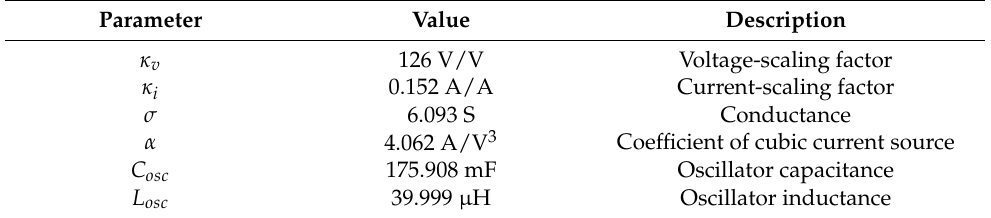
Table 3. Output parameters